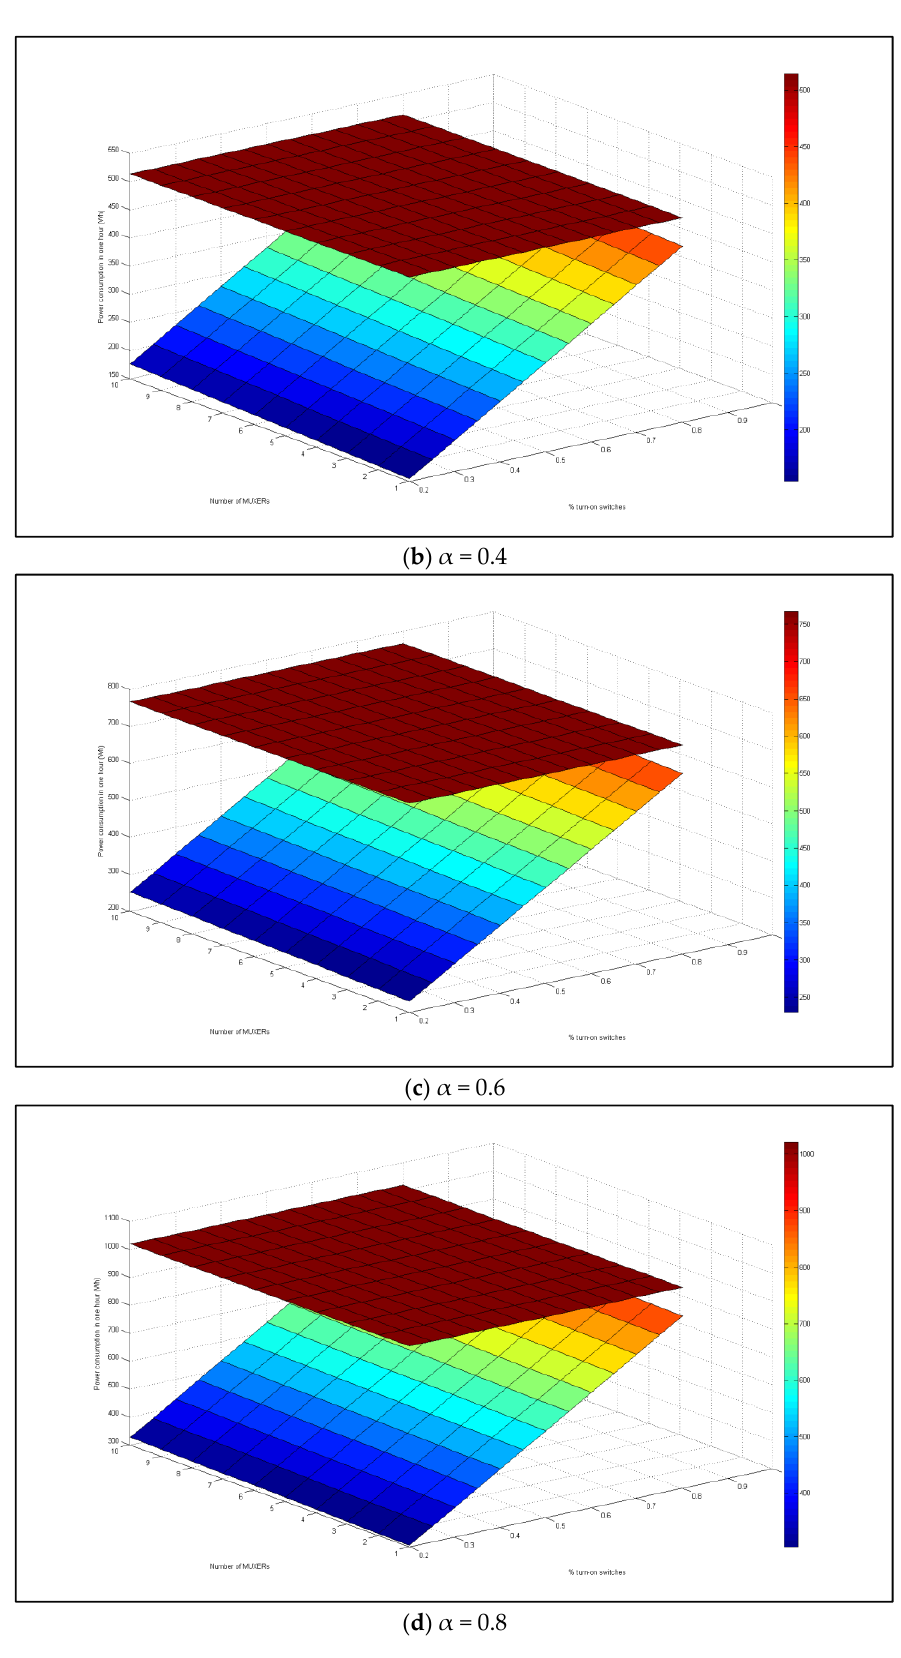
Figure 13. Power consumption of model 1 and model 2 with n = 10 switches, and α = (0.1, 0.4, 0.6, 0.8.